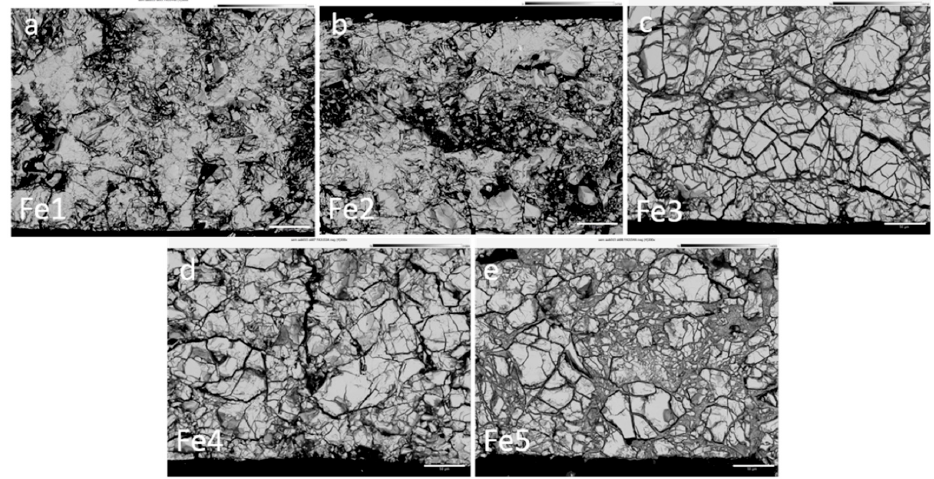
Figure 9. SEM micrographs of the negative electrodes of cells ( a ) Fe1, ( b ) Fe2, ( c ) Fe3, ( d ) Fe4 and ( e ) Fe5 after cycle life testing at 50 °C. The scale bar represents 50 µm.